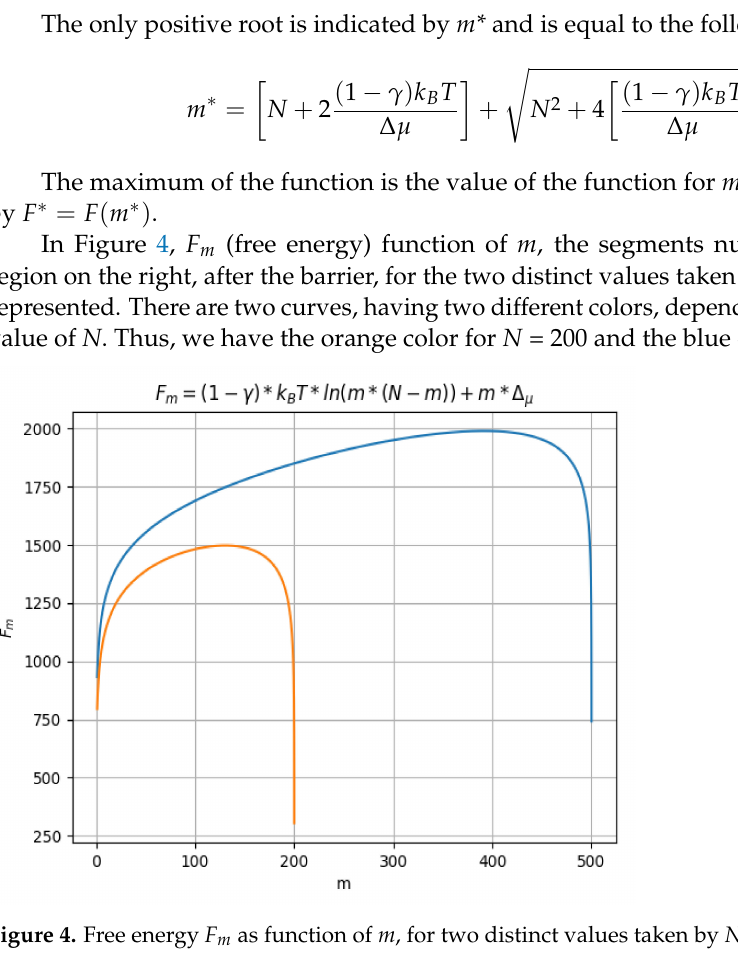
Figure 4. Free energy F m as function of m , for two distinct values taken by N